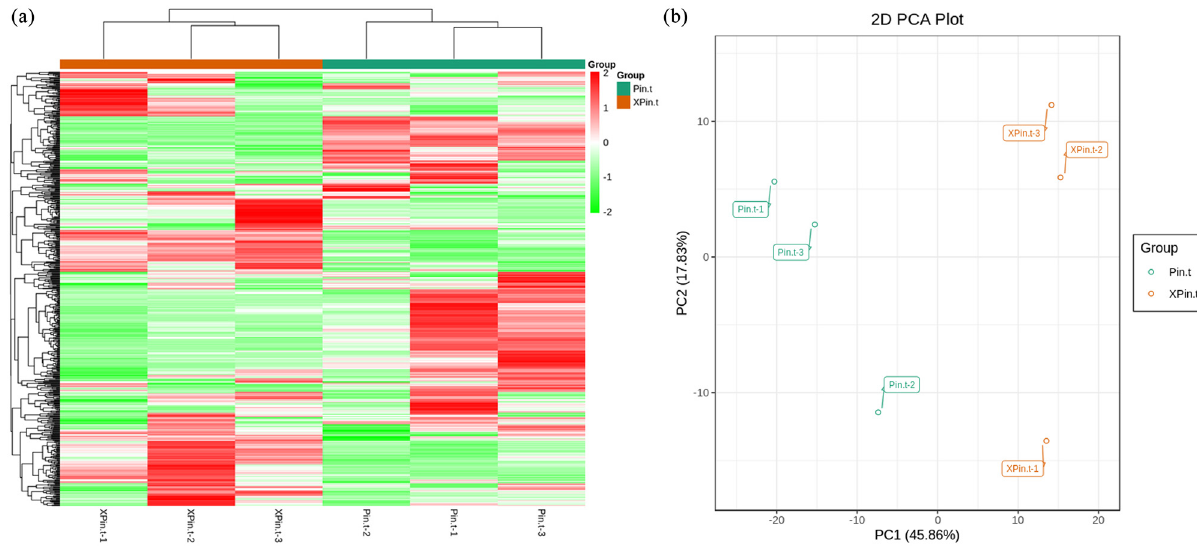
Figure 2: Analysis of the identi fi ed metabolites. ( a ) Cluster analysis of the identi fi ed metabolites in Pin.t and XPin.t. ( b ) PCA of Pin.t and XPin.t.